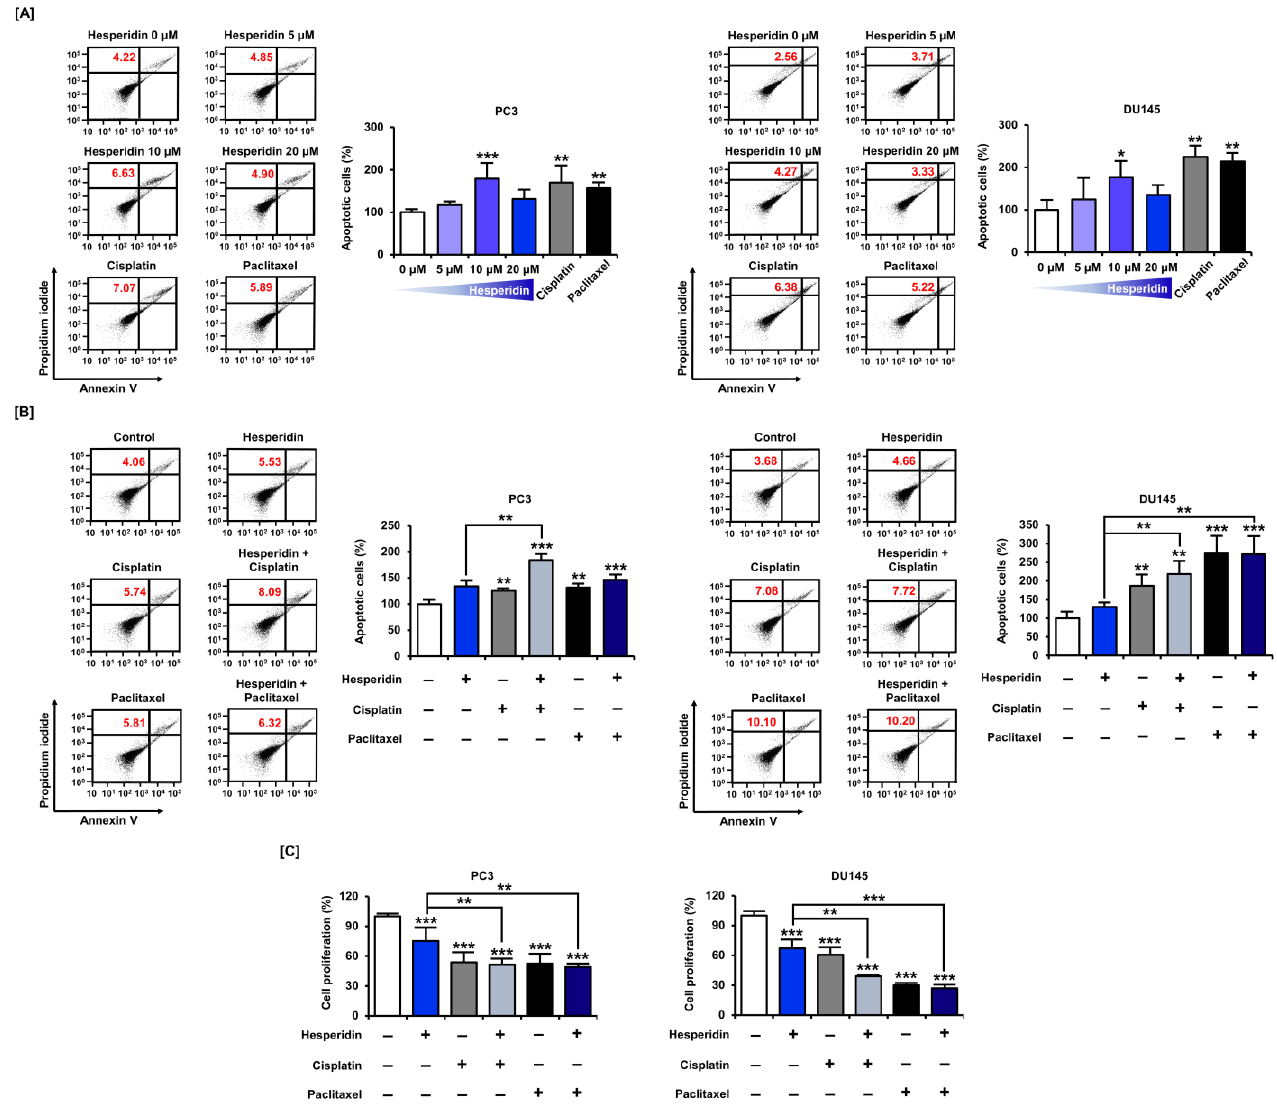
Figure 8. Effect of hesperidin on the apoptosis of prostate cancer cells. ( A ) Flow cytometry detection of apoptosis in PC3 and DU145 cells in response to hesperidin (0, 5, 10, and 20 μM), cisplatin (5 μM), and paclitaxel (5 μM) for 48 h. ( B ) Flow cytometry detection of apoptosis in PC3 and DU145 cells in response to combined treatment with hesperidin (20 μM) and cisplatin (5 μM) or paclitaxel (5 μM) for 48 h. The percentage of late apoptotic cells (upper right quadrant) in the treated group was com- pared to that in control. ( C ) Relative proliferation of PC3 and DU145 cells was verified after co- treatment with hesperidin (20 μM) and cisplatin (5 μM) or paclitaxel (5 μM) for 48 h. Statistical significance is denoted by asterisks for all results of the arithmetic mean ( n = 3) (* p < 0.05, ** p < 0.01, and *** p < 0.001).